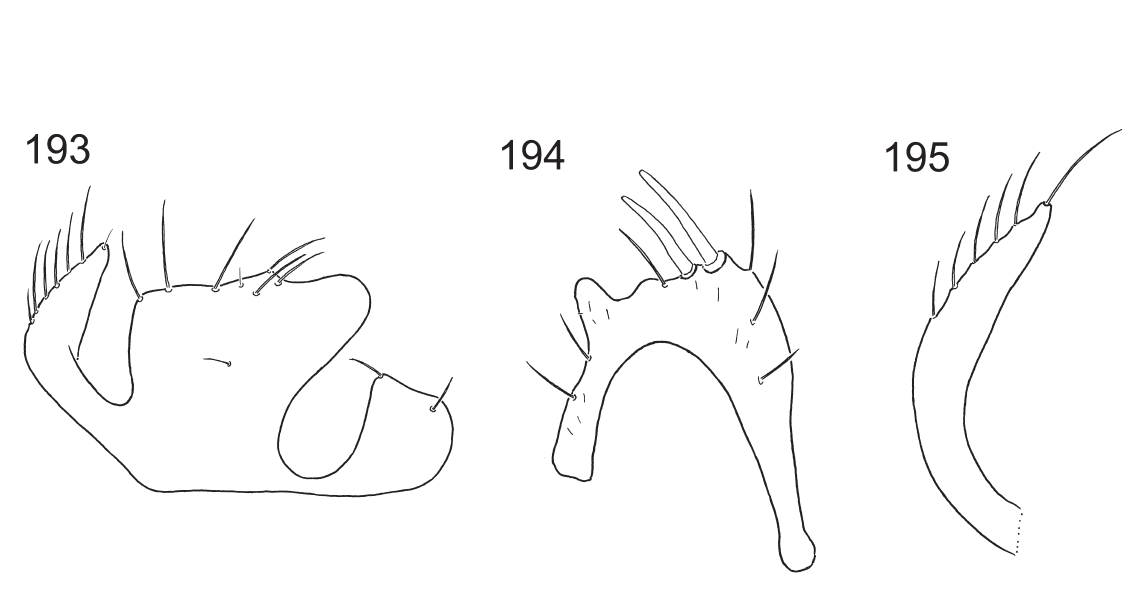
Figs 193-195. Nanodromia spinulosa sp. nov., ♂ terminalia. 193 . right surstylus, dorsal view. 194 . fused cerci bearing spines, dorsal view. 195 . left surstylus, lateral